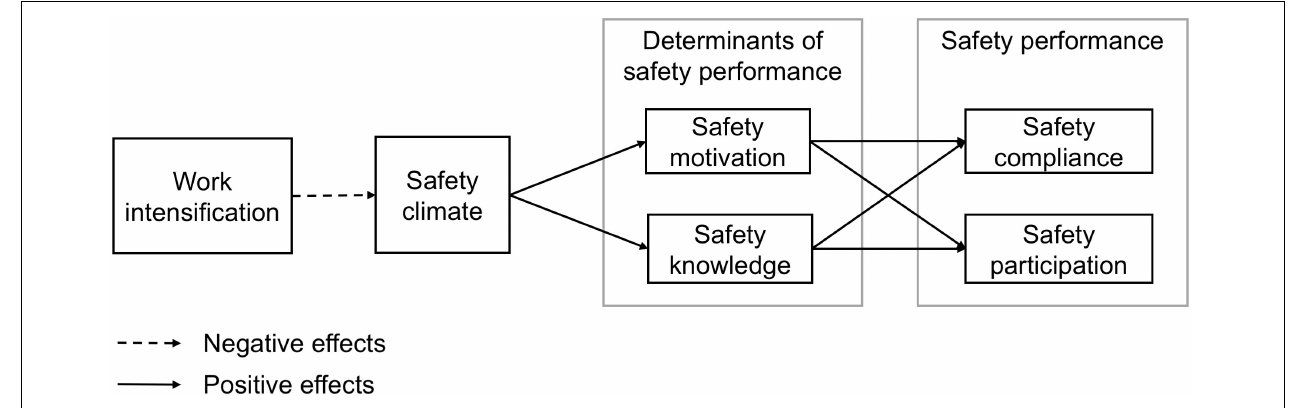
FIGURE 1 | Conceptual model of the relationships between work intensification on safety compliance and safety participation via safety climate and safety motivation resp. safety climate and safety knowledge.